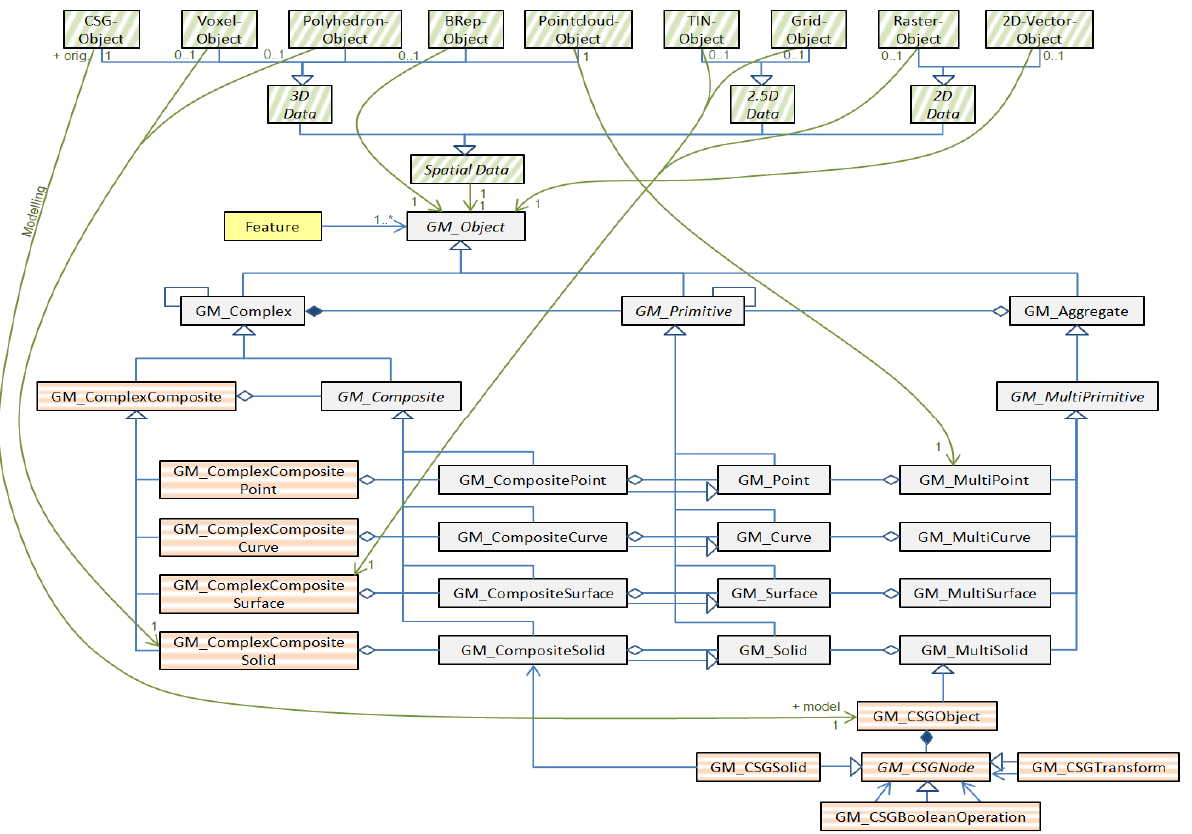
Figure 1. Hybrid data